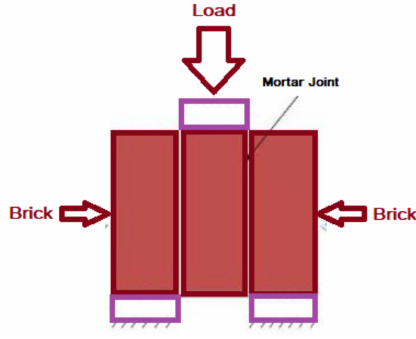
Figure 3. Triple shear test mechanism.